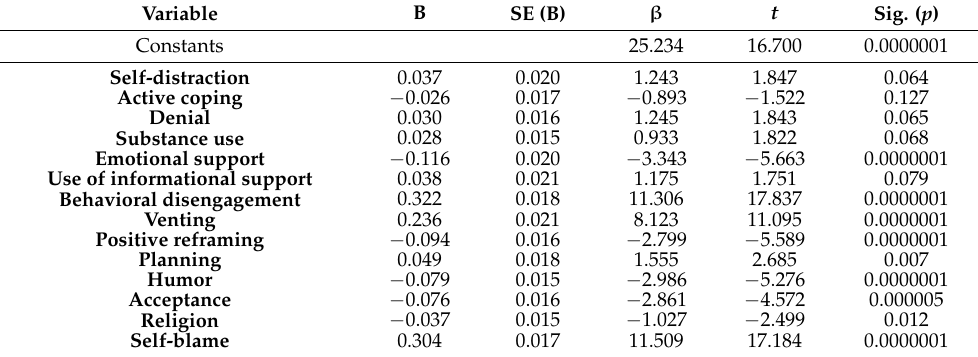
Table 5. Summary of multiple regression analysis (N = 2157).